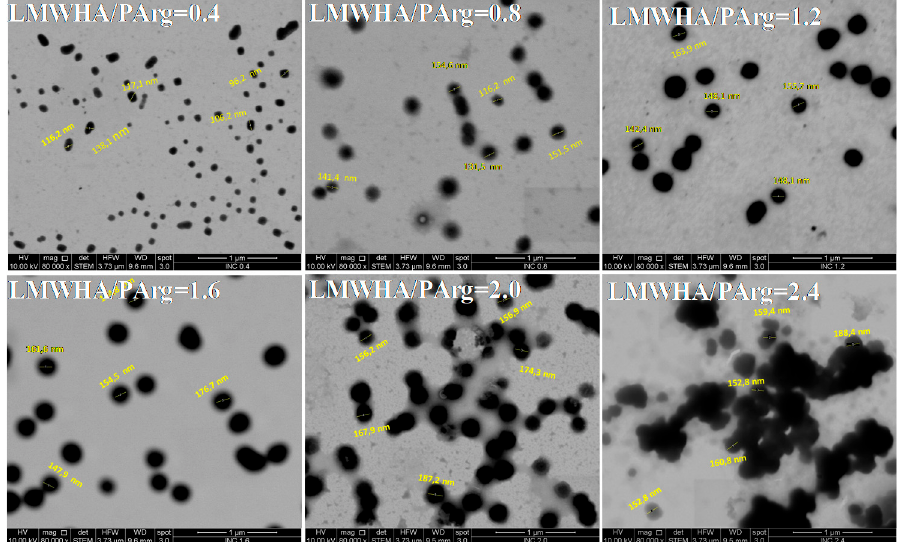
Figure 2. Scanning transmission electron microscopy (STEM) images of ionic nanocomplexes (INC) containing LMWHA and PArg at a ratio of 0.4, 0.8, 1.2, 1.6, 2.0, and 2.4 (scale bar of 1 µm).